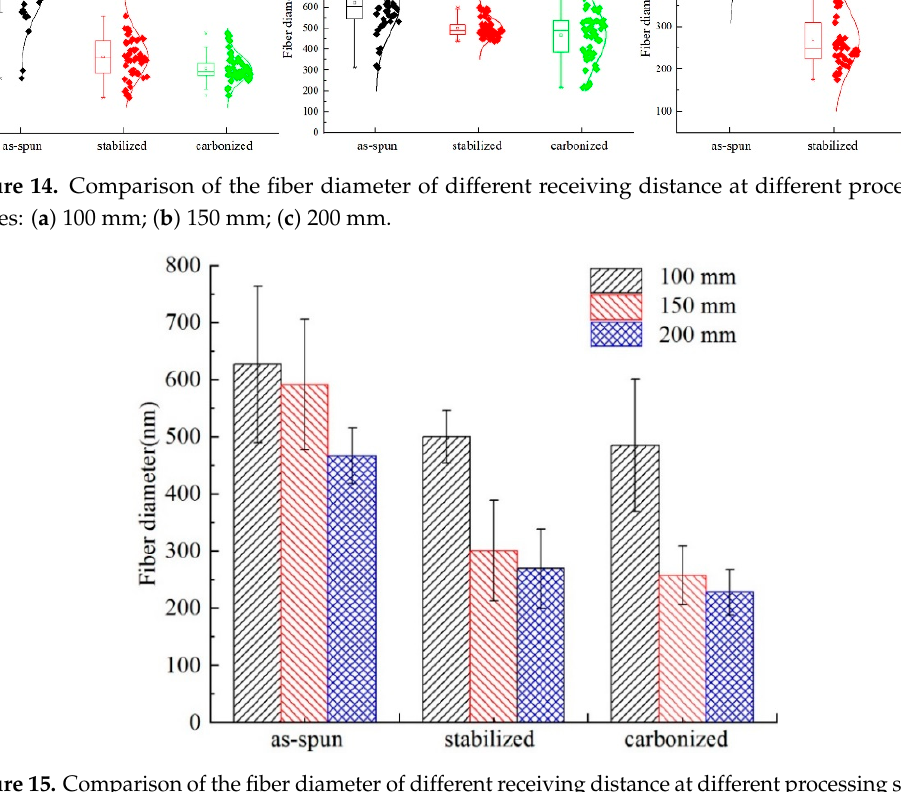
Figure 15. Comparison of the fiber diameter of different receiving distance at different processing stages.